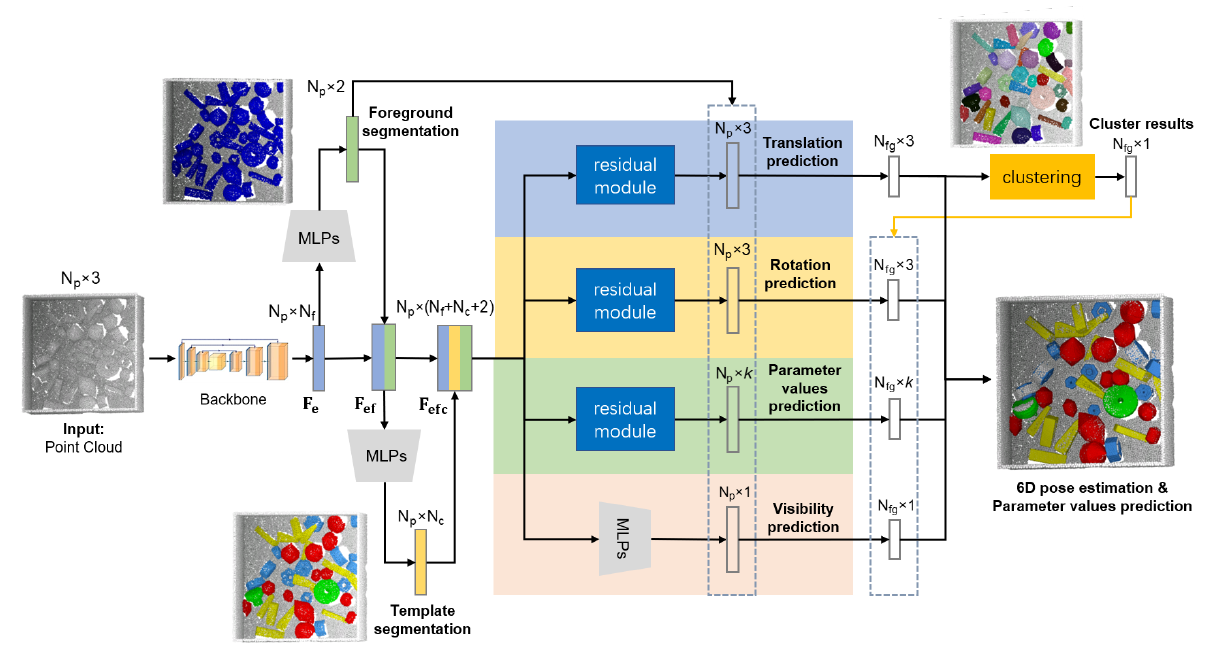
Figure 5. Architecture of Multi-templates Parametric Pose Network